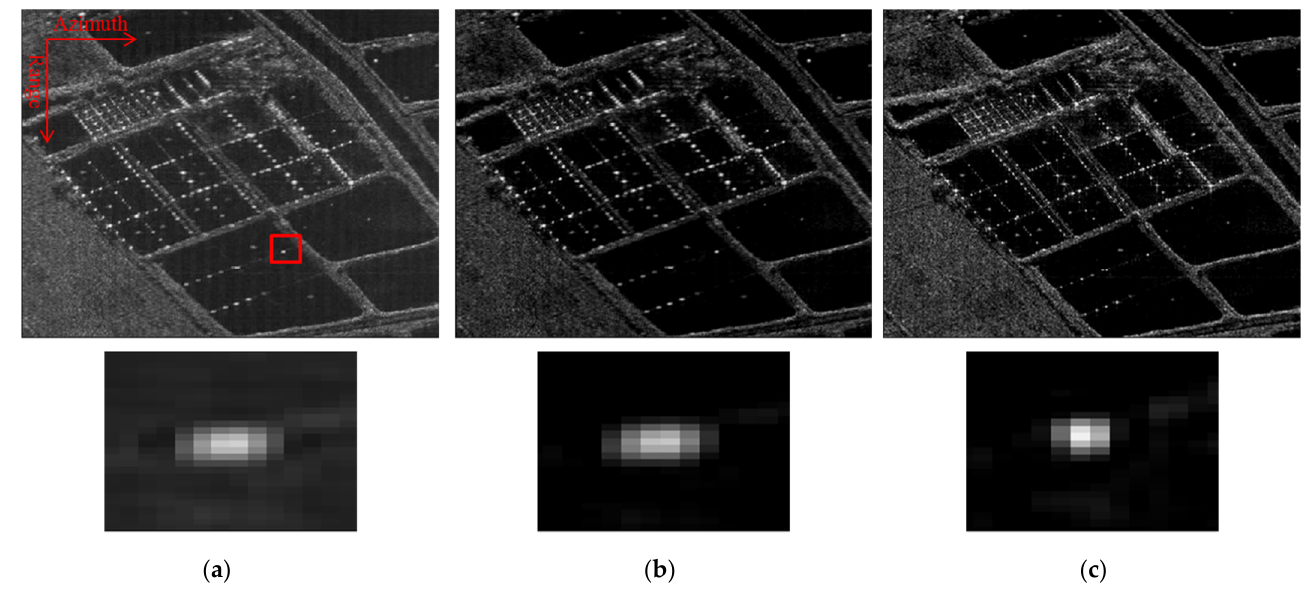
Figure 8. Imaging results of scene A using different methods. ( a ) PGA; ( b ) method in [20]; ( c ) proposed method.